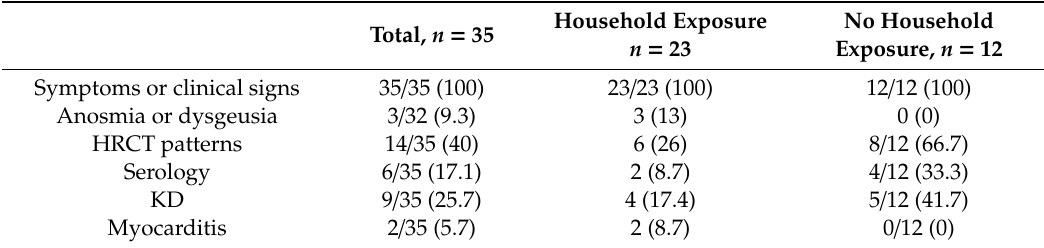
Table 2. Description of the clinical and radiological profile of the 35 children with a negative RT-PCR in nasopharyngeal swab. Household Exposure No Household Total, n = 35 n = 23 Exposure, n = 12 Symptoms or clinical signs 35 / 35 (100) 23 / 23 (100) 12 / 12 (100) Anosmia or dysgeusia 3 / 32 (9.3) 3 (13) 0 (0) HRCT patterns 14 / 35 (40) 6 (26) 8 / 12 (66.7) Serology 6 / 35 (17.1) 2 (8.7) 4 / 12